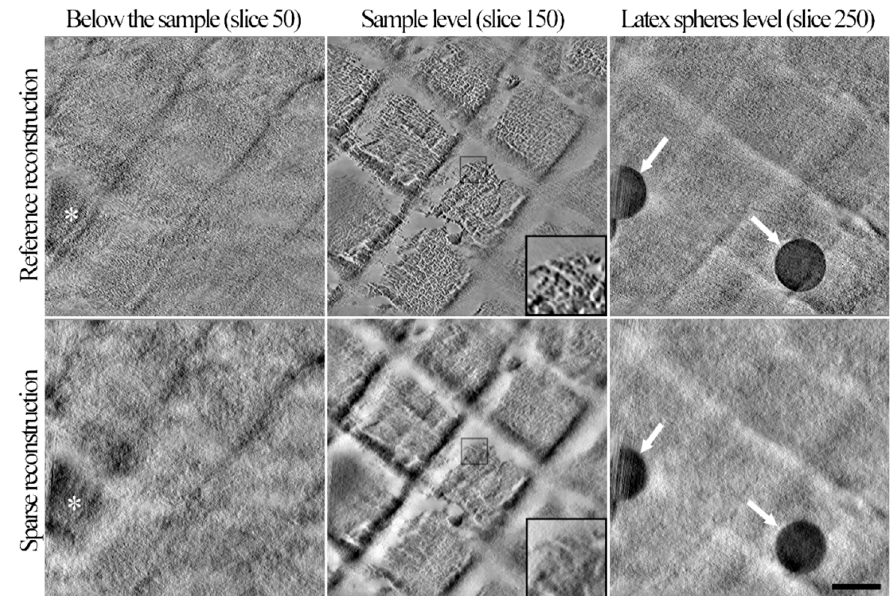
Figure 4. Comparison of the reference and sparse reconstructions. The reference reconstruction ( upper row ) has been computed using fully-collected images whereas the sparse reconstruction ( lower row ) has been computed using sparse images containing 6.25% of the pixels. For each reconstructed volume, three Z-slices were extracted: (i) below the sample (left column, Z-slices 50), (ii) at the level of the Au/Pd coating (center column, Z-slices 150) and (iii) above the sample at the level of the latex spheres (right column, Z-slices 250). The center area of Z-slices 150 (black boxes) has been zoomed-in to better visualize the details on the Au / Pd deposits. Reconstructions artifacts and latex spheres are indicated using white asterisks and white arrows, respectively. The scale bar is 250 nm. The six subfigures have the same